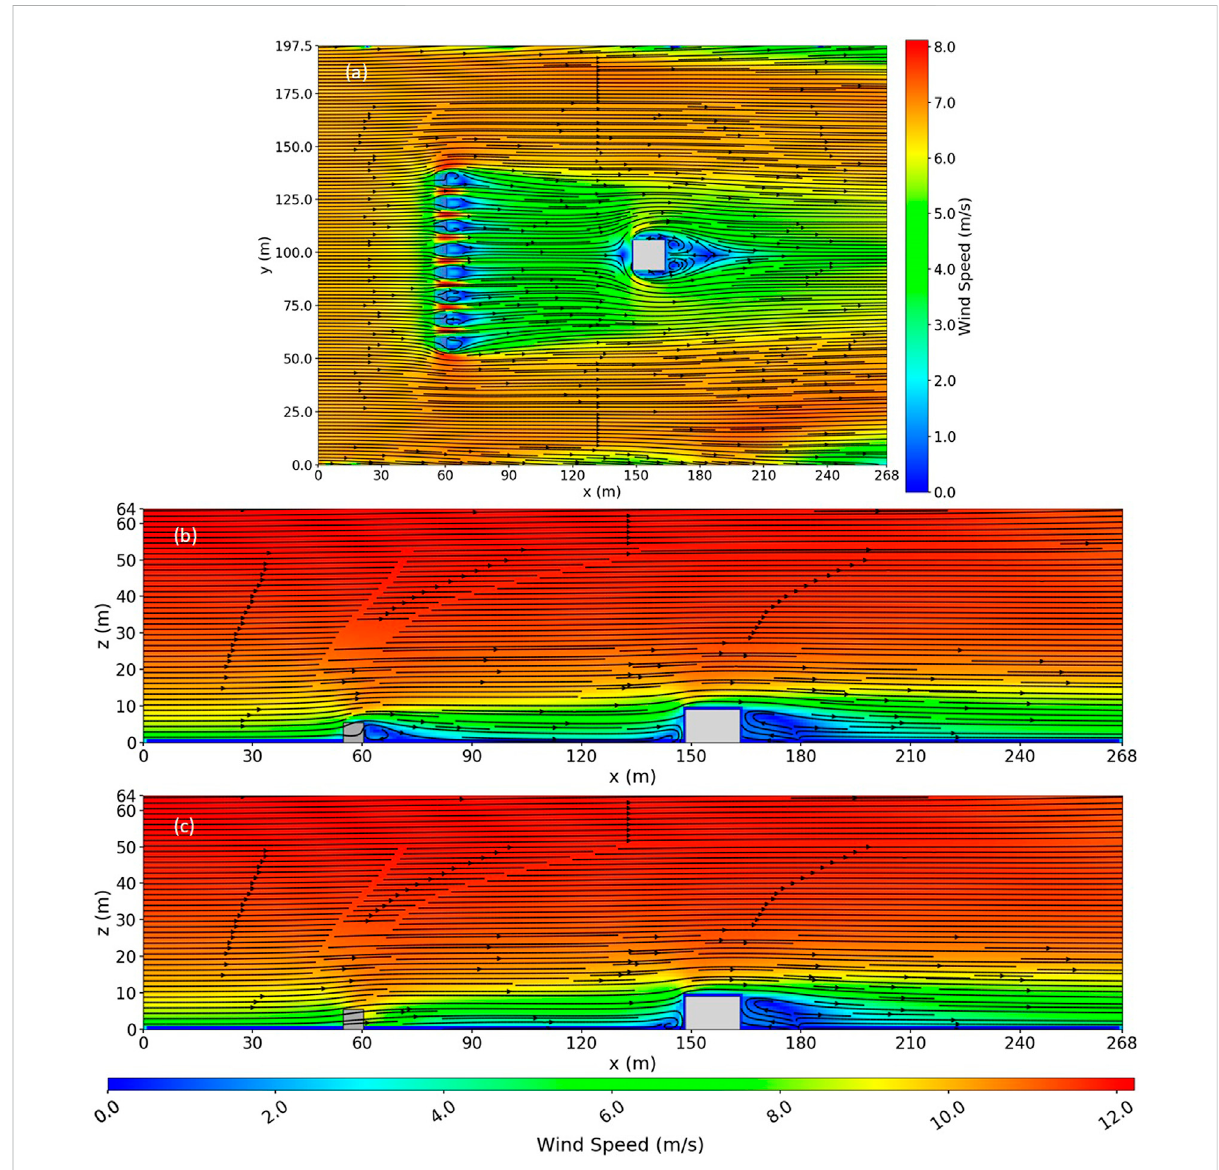
FIGURE 10 Simulated wind fi eld for 1W gap vegetation spacing with both fence and house present in the fl ow. (A) Top view slice at z = 1.4 m, which is the cell center of the second cell above the ground. (B) Side view slice down the middle of the tree just to the left of the middle gap at y = 102 m, just to the left of the center of the house. (C) Side view slice down the middle of the middle gap at y = 96